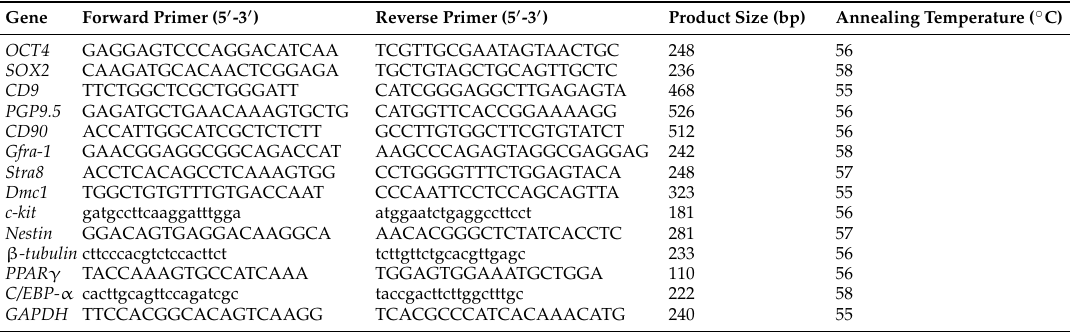
Table 1. Primers of SSC-specific genes and induced cell-specific